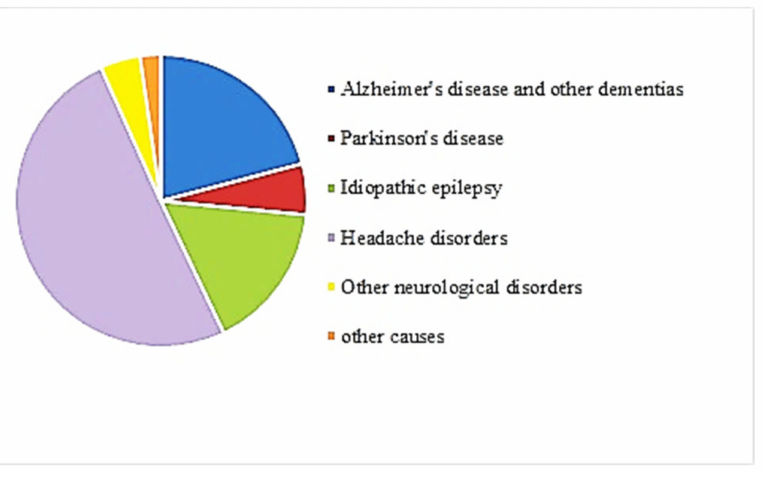
Figure 3. Contribution by neurological disorders to DALYs worldwide, both sexes combined, 2019 [6]. According to the Global Burden of Disease (GBD) 2019, AD and other dementias account for 1% of total DALYs. As mentioned in Figure 4 (Source: Institute for Health Metrics Evaluation. Used with permission. All rights reserved.), countries with the highest age-standardized neurological disorders DALYs rates were: Japan 1612.77, Italy 1109.73,